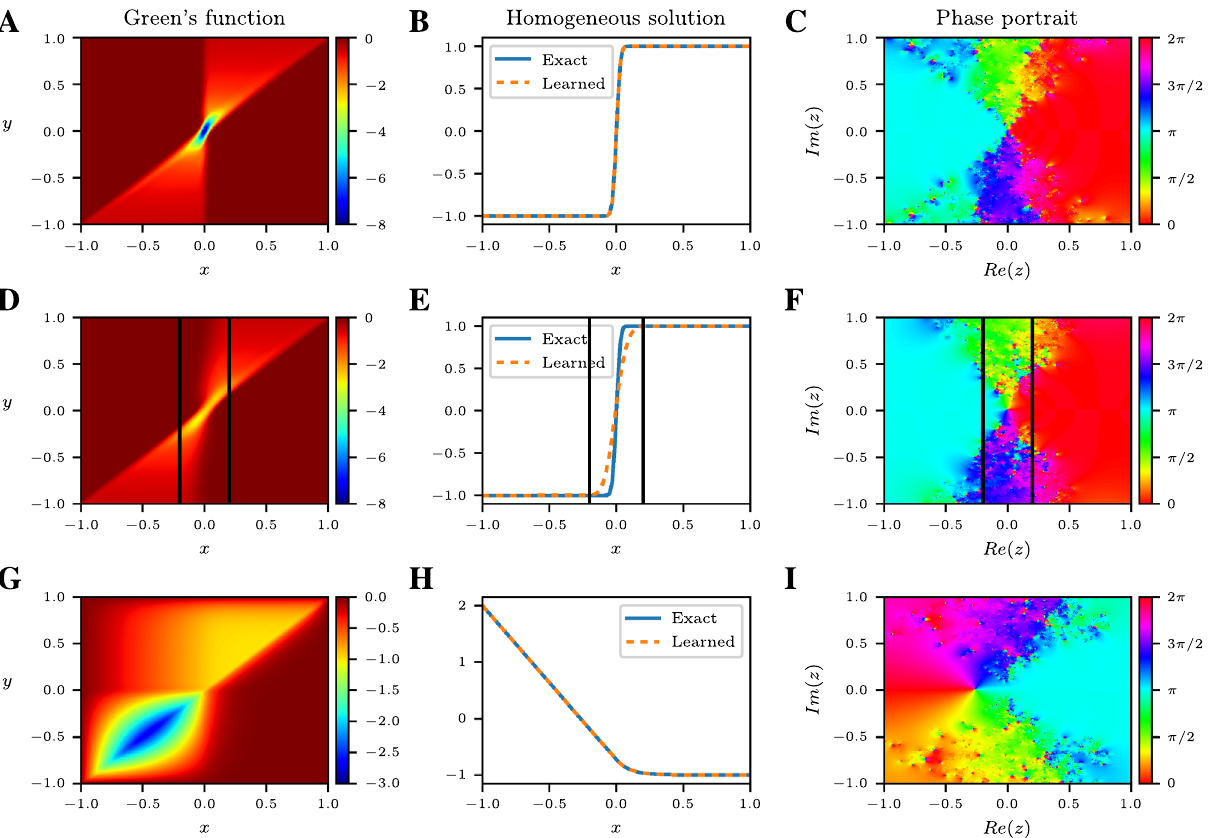
Figure 3. Green’s functions learned by rational neural networks. ( A ) Green’s function of a differential operator with a viscous shock at x = 0 , learned by a rational NN. ( B ) Learned and exact (computed by a classical spectral method) homogeneous solution to the differential equation with zero forcing term. ( C ) Phase portrait of the homogeneous rational NN evaluated on the complex plane. ( D–F ) Similar to ( A–C ), but without any system’s response measurements in x ∈ [− 0.2, 0.2 ] (see vertical black lines) near the shock. ( G ) Learned Green’s function and homogeneous solution ( H ) of an advection–diffusion operator with advection occurring for x ≥ 0 . ( I ) Phase portrait of the homogeneous NN on the complex